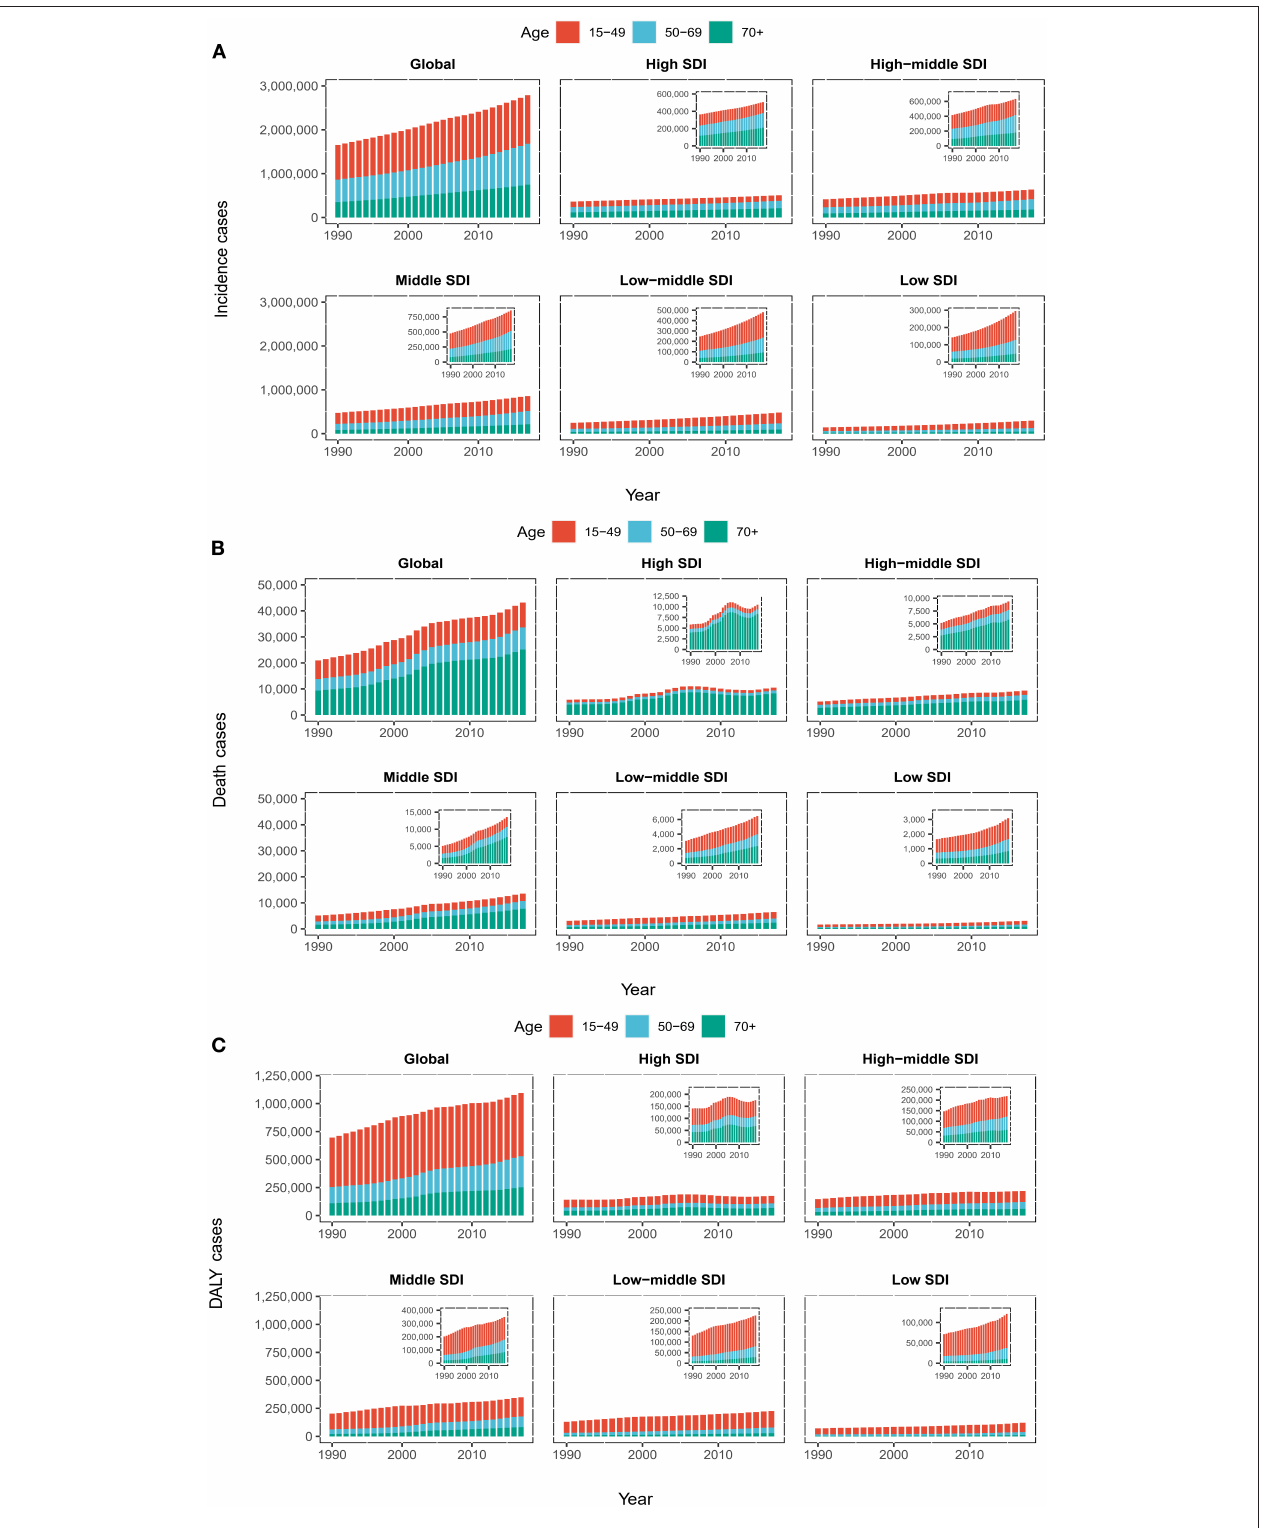
FIGURE 2 | The proportion of the three age groups (15–49 years, 50–69 years and 70 + years) for myocarditis incidences (A) , deaths (B) , and DALY (C) cases globally and in five SDI quintiles between 1990 and 2017. SDI, Socio-Demographic Index; DALY, disability-adjusted life year.